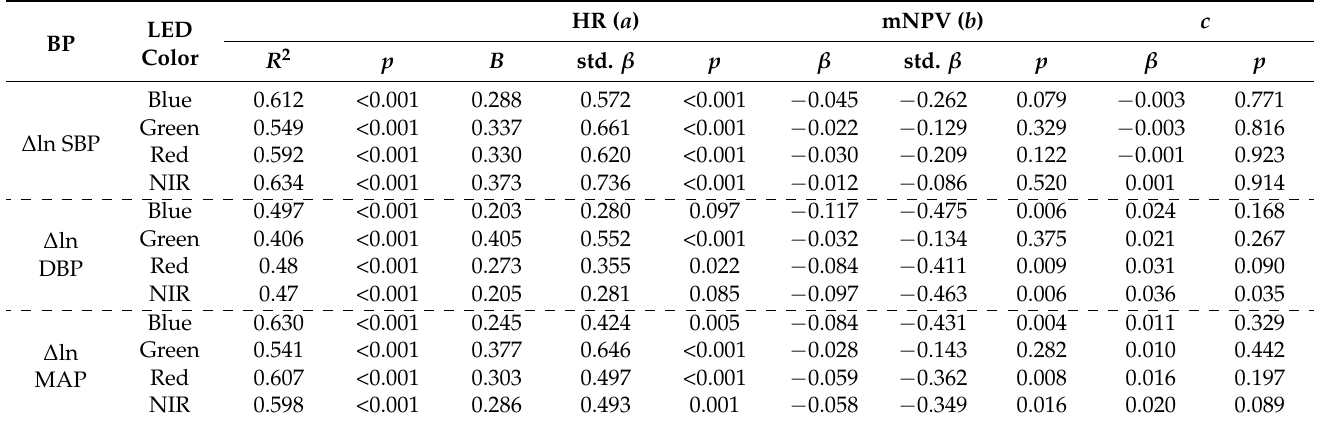
Table 3. Results of multiple linear regression analysis of BP estimation at each wavelength.